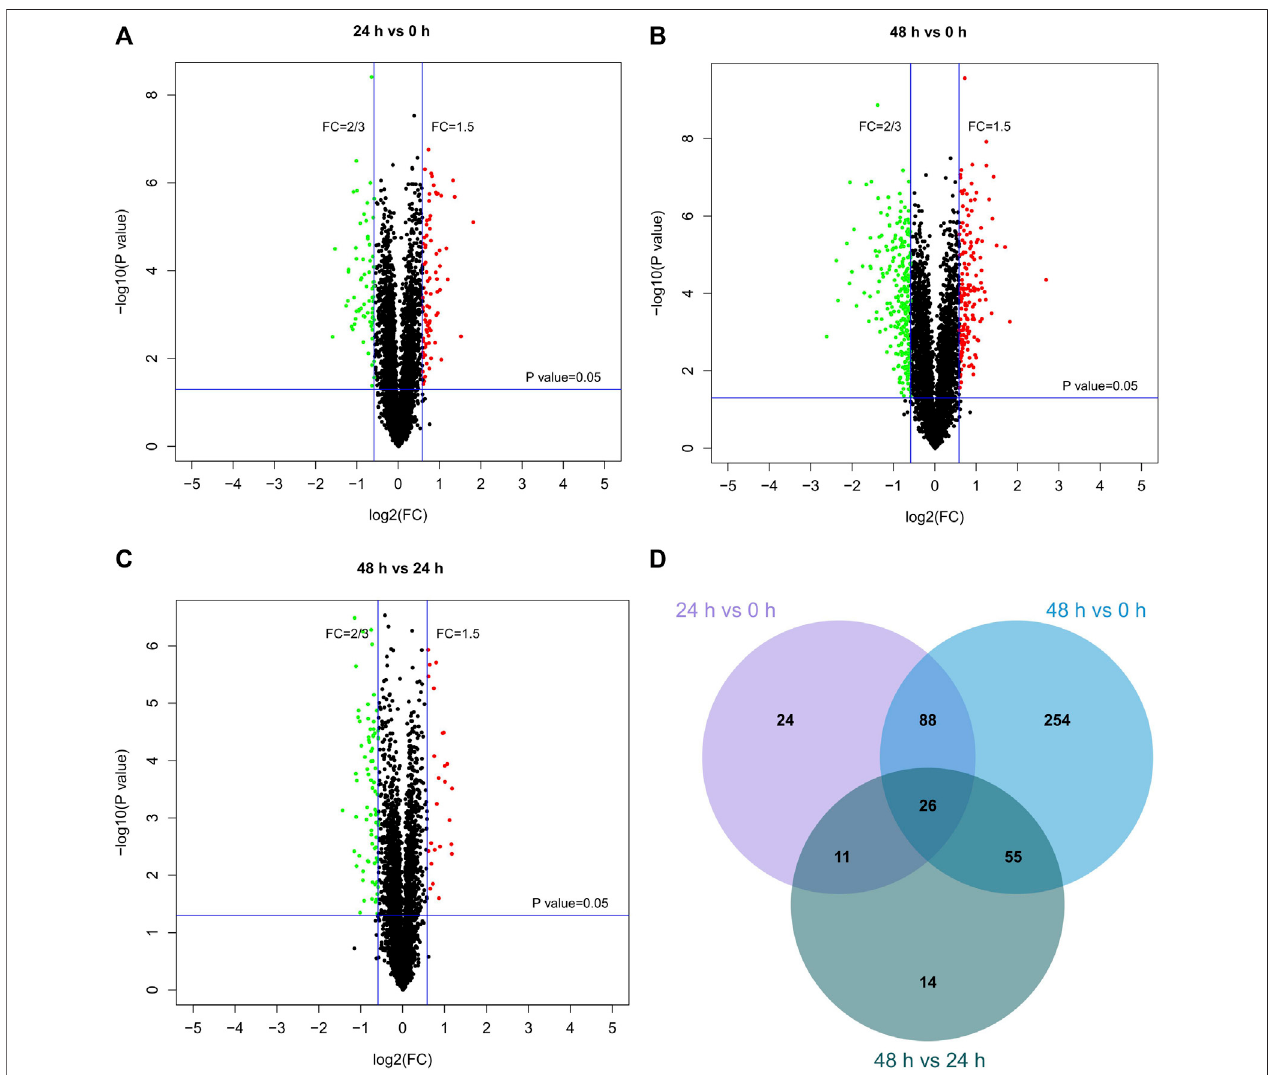
FIGURE 6 | Differentially expressed proteins in different groups. (A – C) Volcano plots for the proteomics characterization of kaempferide in B16F10 cells. (D) Venn diagram of differentially expressed proteins overlapping in the comparison of different groups.